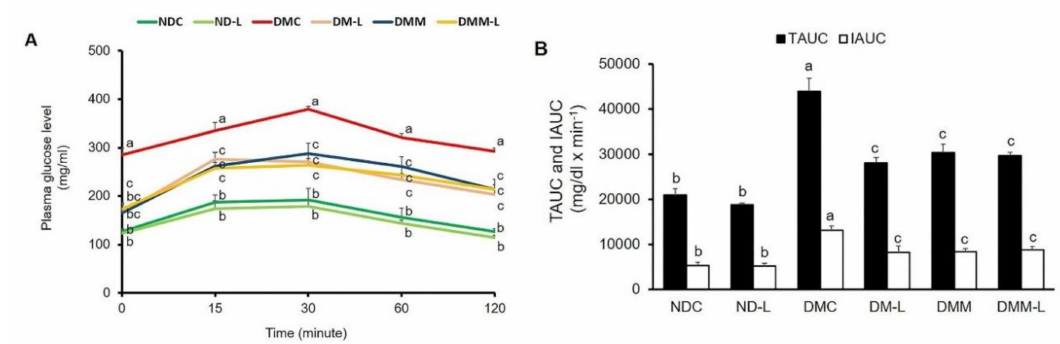
Figure 2. E ff ects of L. paracasei HII01 on the OGTT in experimental group. ( A ) Glucose response; ( B ) area under the curve for glucose. NDC, normal control rats; ND-L, normal control rats supplemented with L. paracasei HII01 (10 8 CFU / day); DMC, diabetic rats control; DM-L, diabetic rats supplemented with L. paracasei HII01 (10 8 CFU / day); DMM, diabetic rats treated with metformin 30 mg / kg; DMM-L, diabetic rats supplemented with combination of L. paracasei HII01 (10 8 CFU / day) and metformin 30 mg / kg; OGTT, oral glucose tolerance test; TAUC, total area under the curve; IAUC, incremental area under the curve. All data are expressed as mean ± SEM. Di ff erent lowercase letters indicate significant di ff erences among di ff erent groups ( p < 0.05).